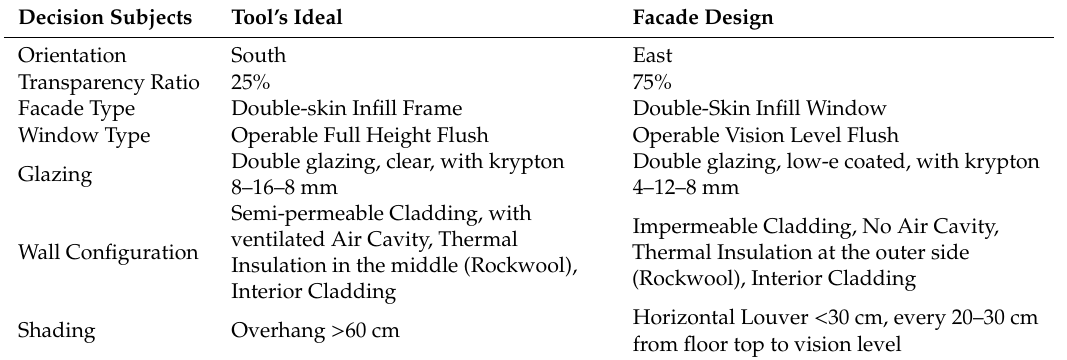
Table 4. Comparison of design decisions for Ankara.